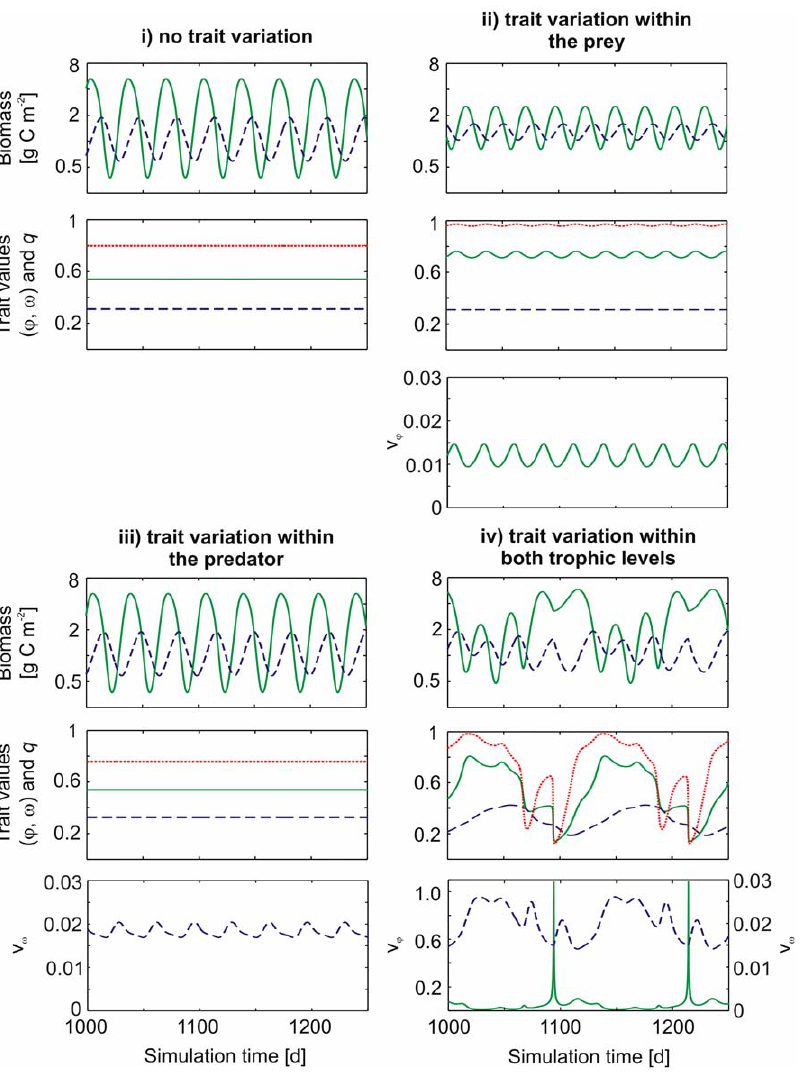
Figure 1. Model dynamics. Simulated prey (green solid) and predator biomass (blue dashed) (top), mean trait values, Q (green solid) and v (blue dashed) and food-suitability q (red dotted) (middle) and variances of the trait values, v Q (green solid) and v v (blue dashed) (bottom, only shown when w 0 ), after a spin-up of 1000 days in ( i ) a model run with constant trait values for predator and prey, ( ii ) a model run with variation in Q , but not v , i.e., only the prey trophic level has the potential for trait variation, ( iii ) a model run with variation in v , but not Q , i.e., only the predator trophic level has the potential for trait variation, and ( iv ) a model run with variation in Q and in v , i.e., both the prey and the predator level have the potential for trait variation. Constants as in Table 1. Initial conditions for all runs were: X (0) ~ 3 , Y (0) ~ 1 , Q (0) ~ 0 : 54 , v (0) ~ 0 : 31 , v Q (0) ~ v v (0) ~ 0 : 06 . Q (0) and v (0) represent the mean values of d). For runs without trait variation v Q and v v were set to zero.